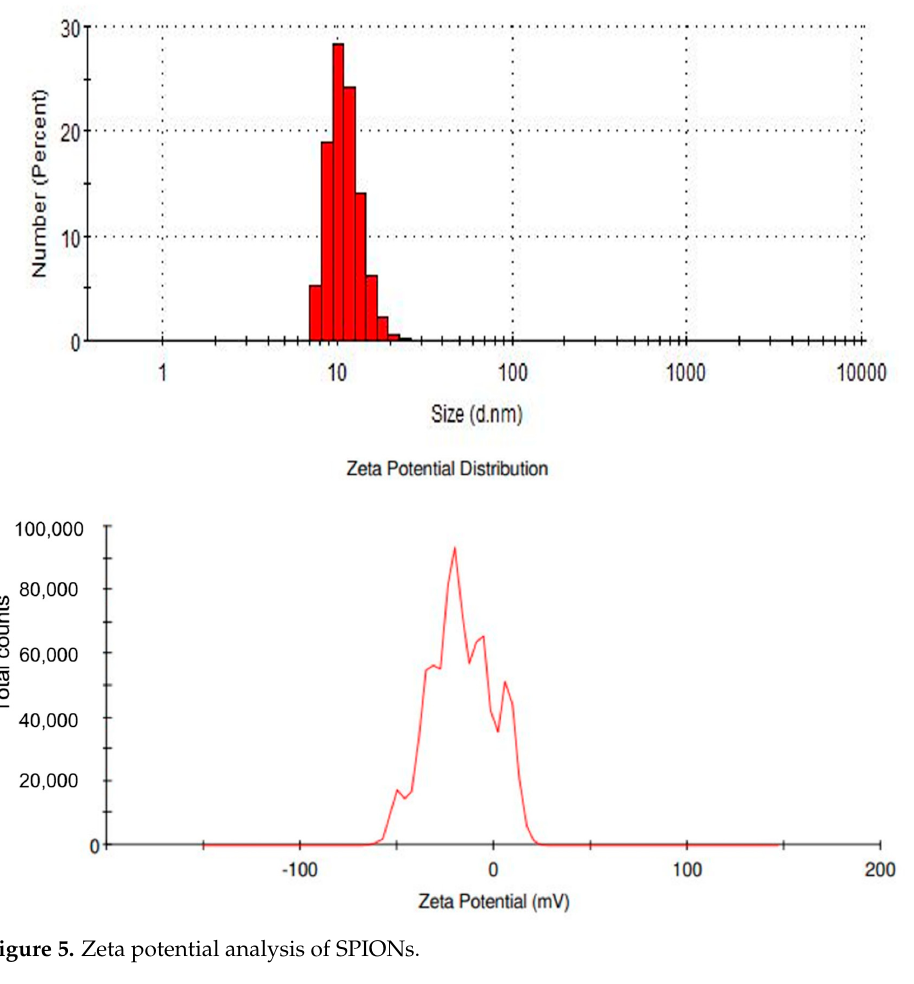
Figure 5. Zeta potential analysis of SPIONs.